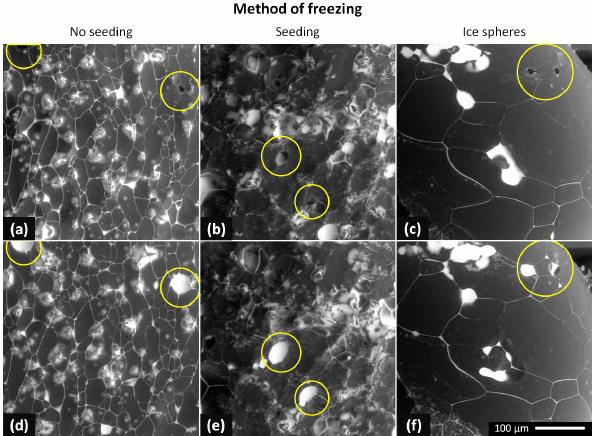
Figure 8. The ESEM images of the partially sublimated frozen samples prepared from the 0.005MCsCl solution: the non-seeded droplet ( a and d , − 25 ◦ C); the seeded droplet ( b and e , − 25 ◦ C); and the ice sphere ( c and f , − 23 ◦ C). The hollows in the internal structure were revealed after the initial sublimation of the ice from the surface ( a , b , and c ). Further sublimation showed the hollows filled with the brine ( d , e , and f ); the time interval between the up- per and the lower images was about 1min. The gray areas represent the ice, while the white regions indicate the CsCl brine.